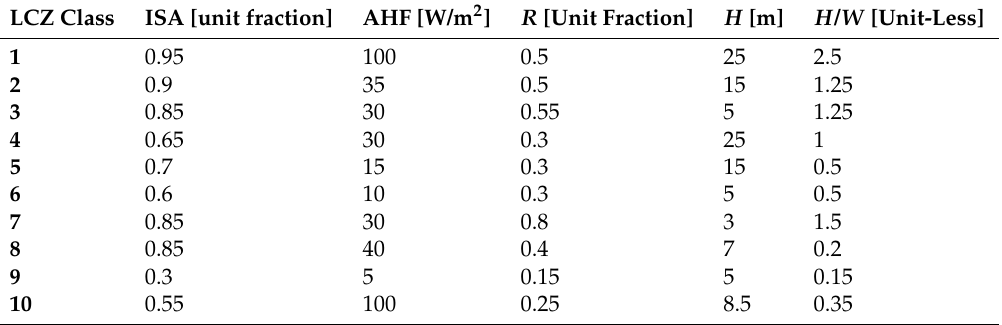
Table A2. Urban canopy parameters per LCZ class, compiled from Stewart and Oke [23] and Stewart et al. [65], including the impervious area fraction (ISA), annual-mean anthropogenic heat flux (AHF), building area fraction ( R ), building height ( H ), and height-to-width ratio ( H / W ).